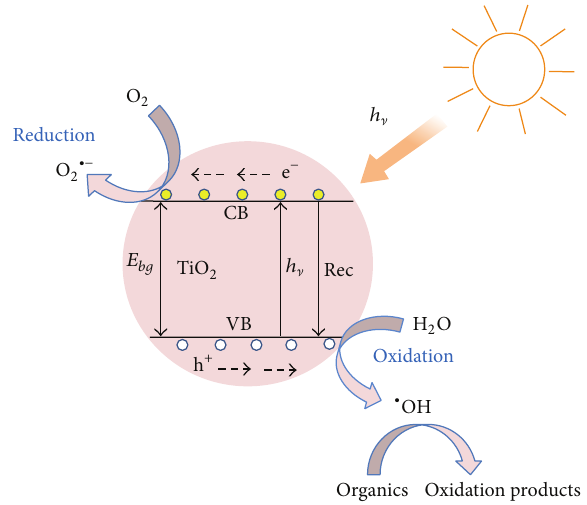
Figure 1: General mechanism of TiO 2 in solar photocatalysis